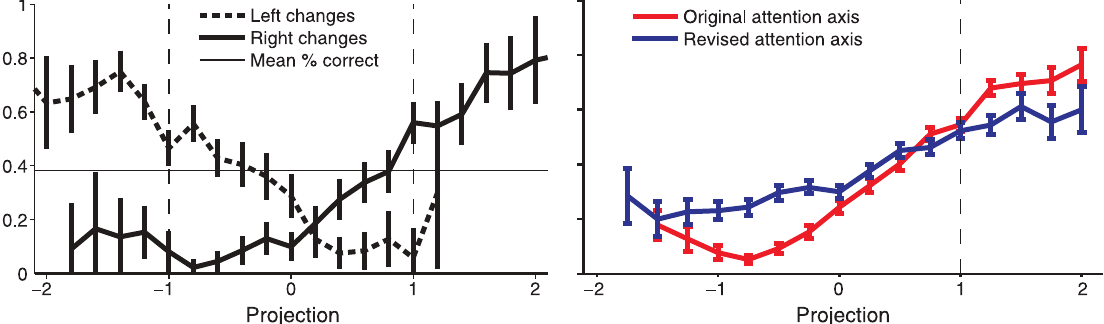
using a single sample from attend-right responses ( A ) and a single sample from attend-left responses ( B ) of a single neuron. In this example, the response estimates A and B are random samples drawn from two uniform distributions that overlap by 50% (Fig 1A, hatched and yel- low). A single-trial test sample ( T ) is also drawn from the attend-right distribution. If the atten- tion axis provides unbiased measures, the expected position for the test sample T on the